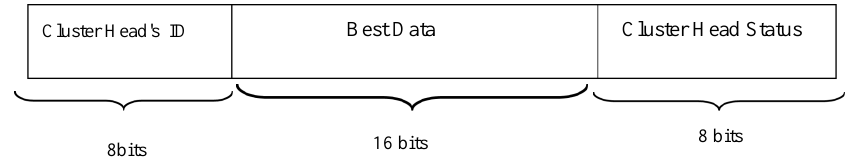
Figure 4. Structure of broadcast message